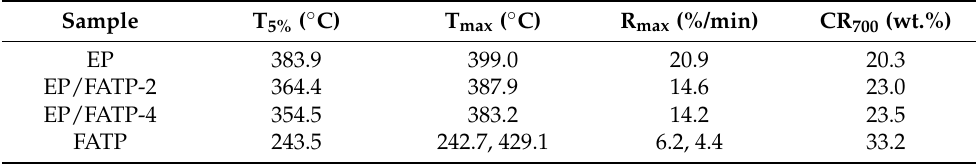
Table 4. Data from TGA and DTG curves measured under nitrogen